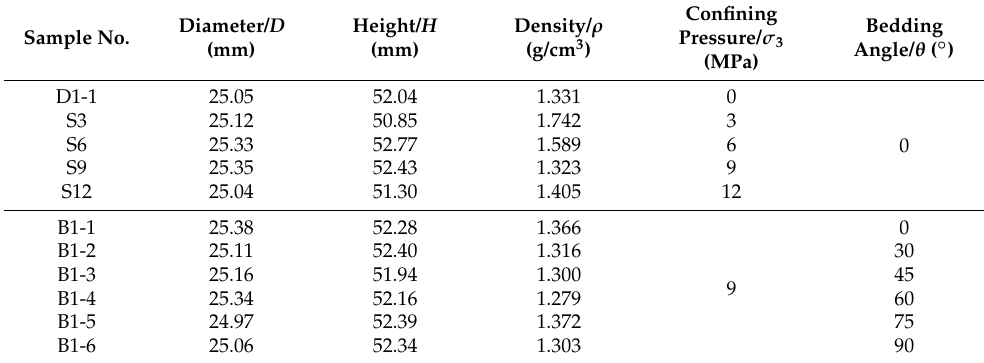
Table 1. Geometric information of coal samples and the experimental